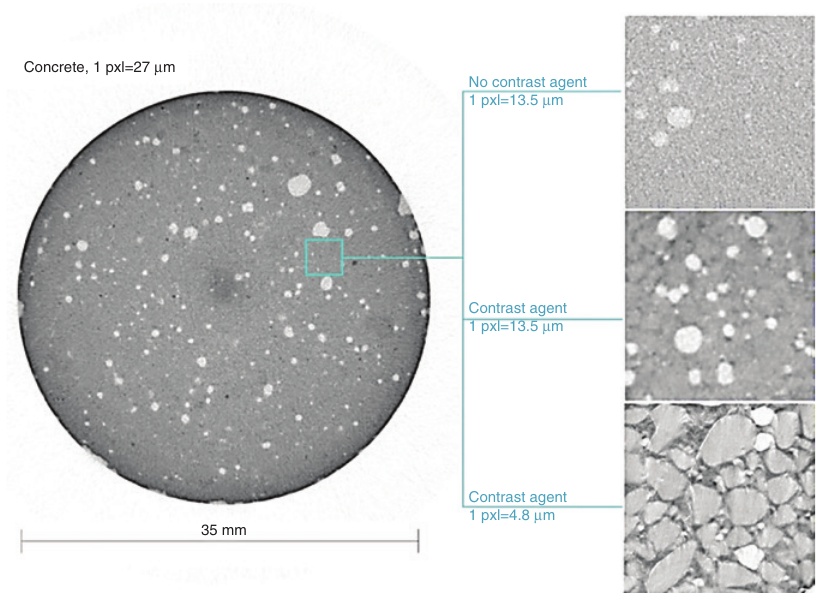
Figure 4: The effect of the iodine staining on the microCT imaging of